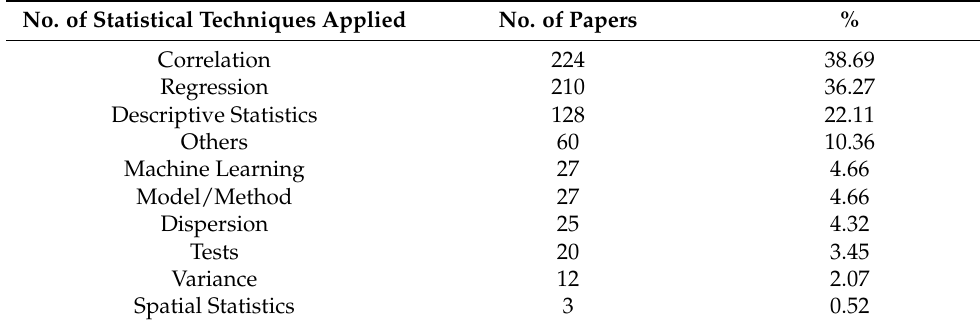
Table 11. Papers by statistical